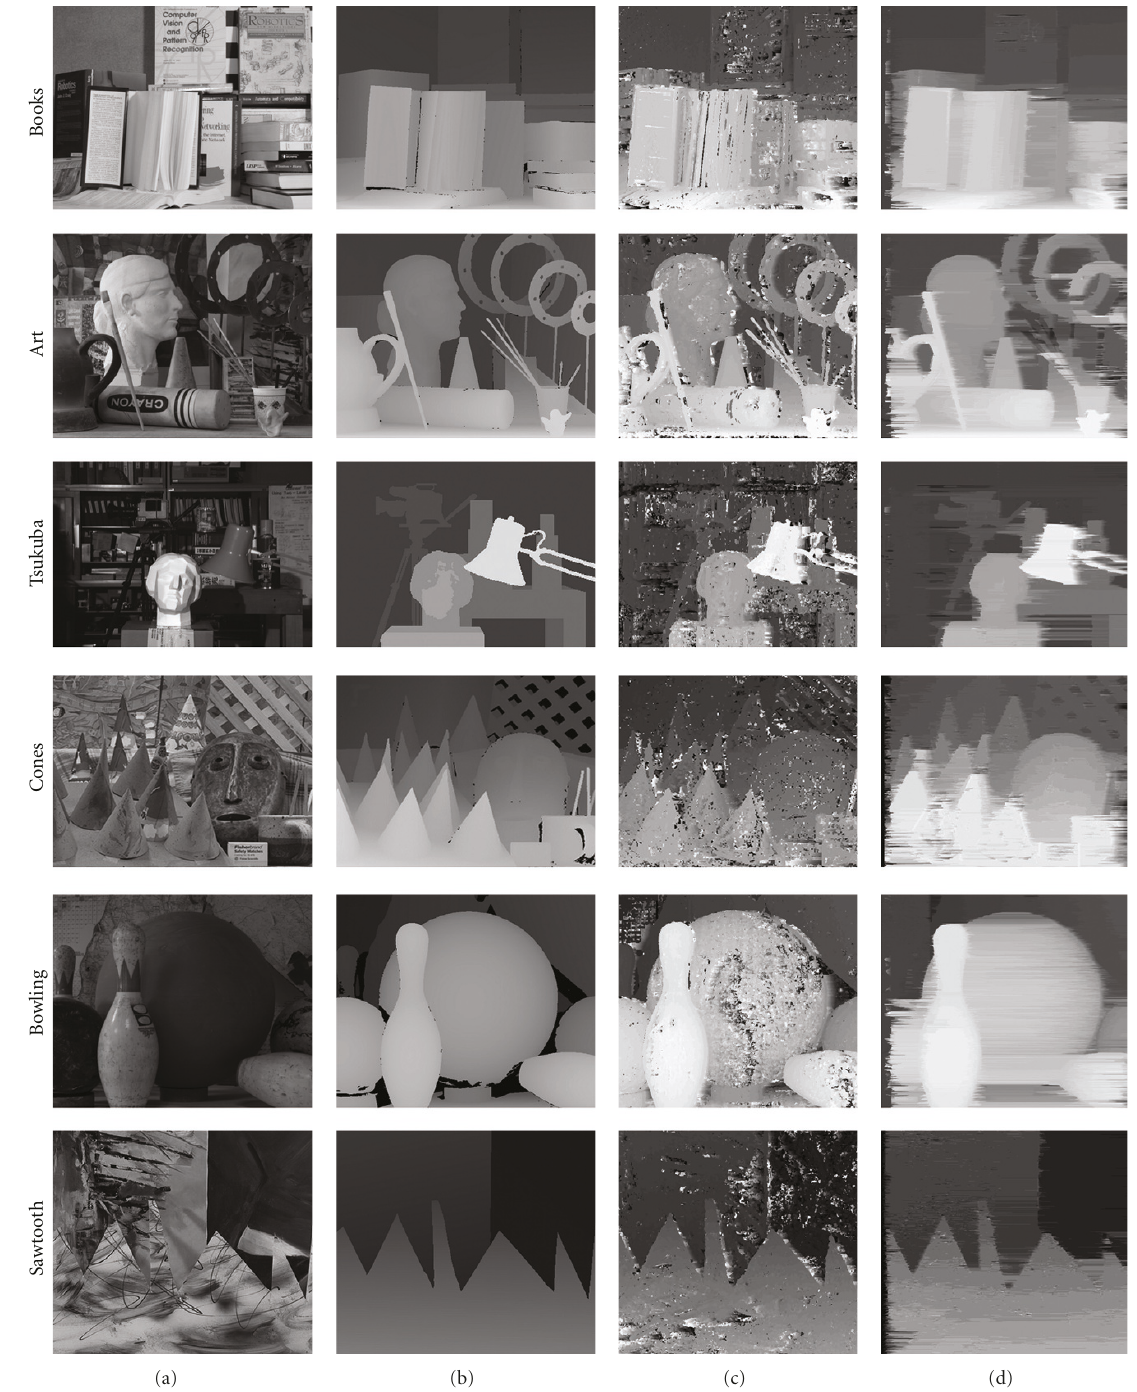
Figure 13: Processing of reference datasets. From top to bottom: Books, Art, Tsukuba, Cones, Bowling, and Sawtooth data-sets. (a) Reference test image, (b) ground truth, (c) processing by the SAD accelerator, and (d) processing by the DP accelerator.